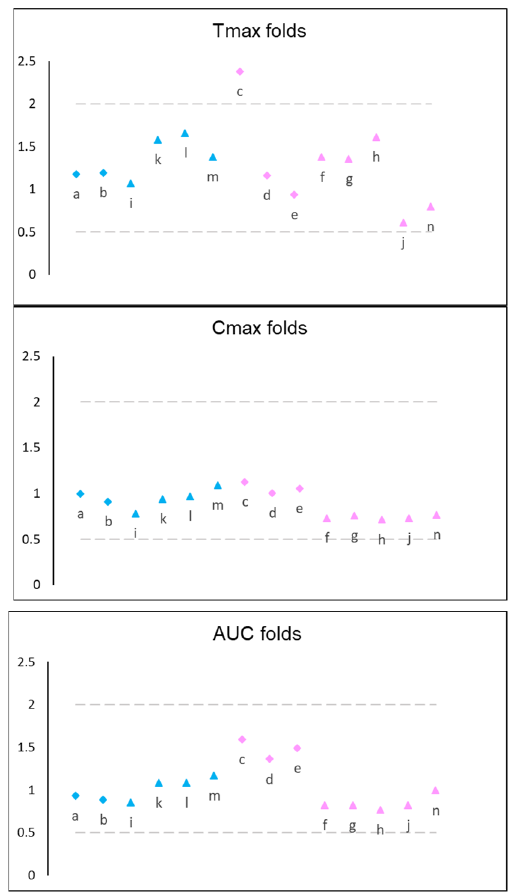
Figure 2. Plotted fold differences for simulated versus observed values. Diamonds indicate healthy volunteers, triangles—Parkinson’s patients, blue color—fasted state, pink color—fed state. Each symbol represents a fold value from each simulation included in Table 2. Latin letters indicate Simulation ID referenced in Table 2.